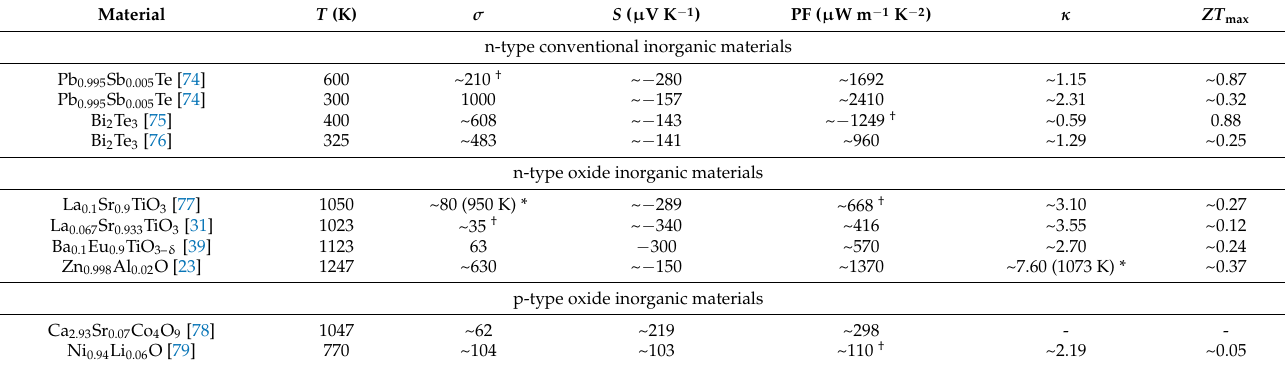
Table 2. Thermoelectric properties of various inorganic materials typically used in inorganic/polymer composites at a stated temperature ( T ). * Data reported at the temperature in brackets. σ is the electrical conductivity, S is the Seebeck coefficient, PF is the power factor and κ is the thermal conductivity. All values are reported at the maximum of the figure of merit, ZT max . † Calculated from literature